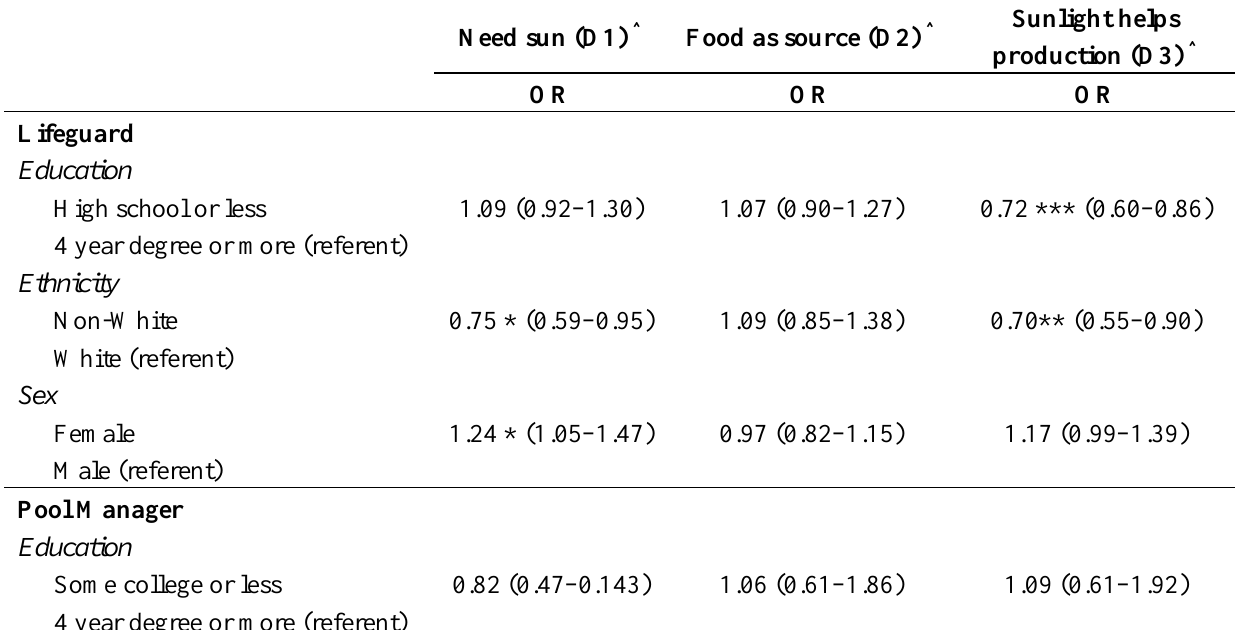
Table 3. Multivariate Ordinal Regression for Beliefs by Demographic